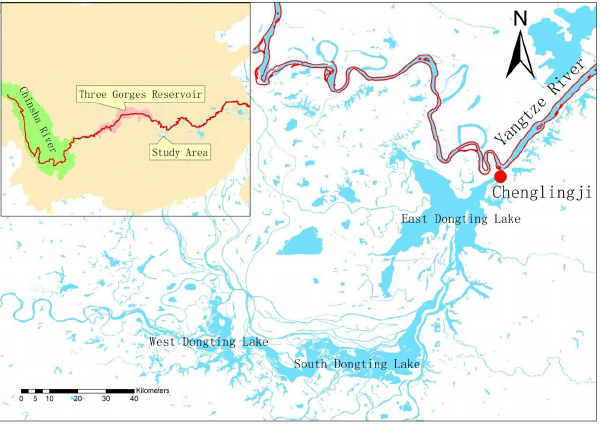
Figure 1. The location of Dongting Lake in the Yangtze River basin.